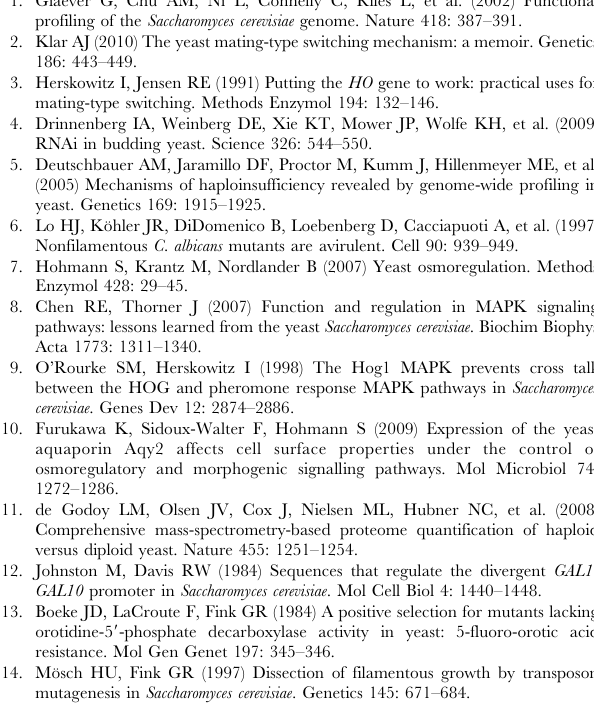
Table S1 Identified mitochondria-related